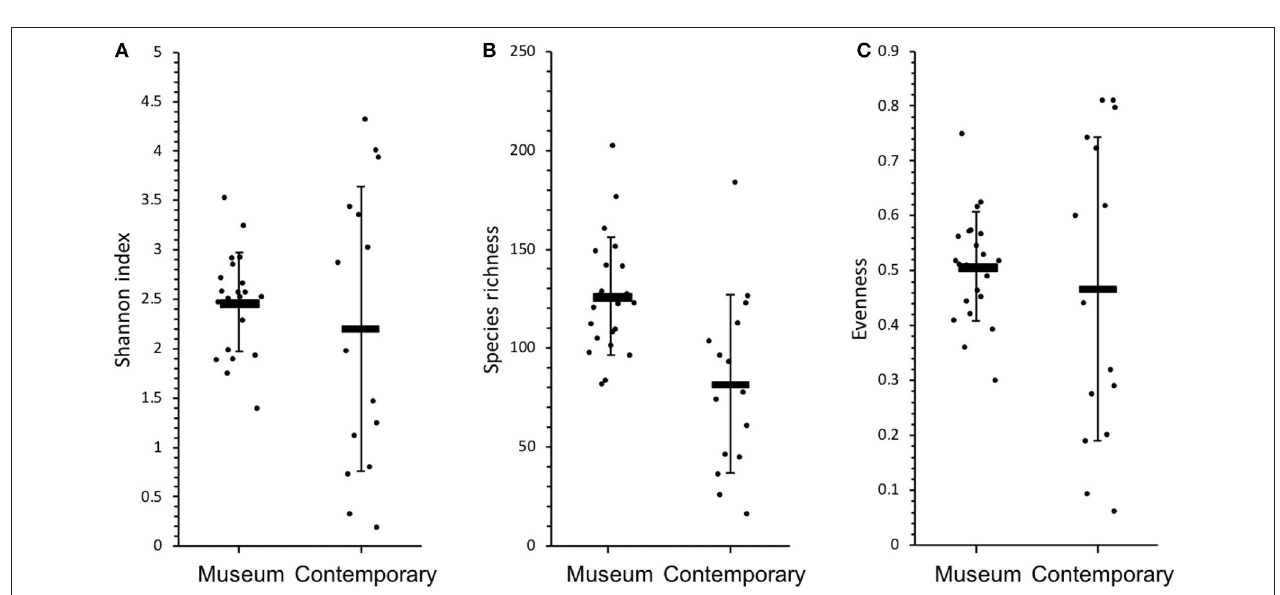
FIGURE 6 | Diversity graphs for all museum and contemporary samples: (A) Shannon index, (B) species richness and (C) evenness. Error bars indicate standard